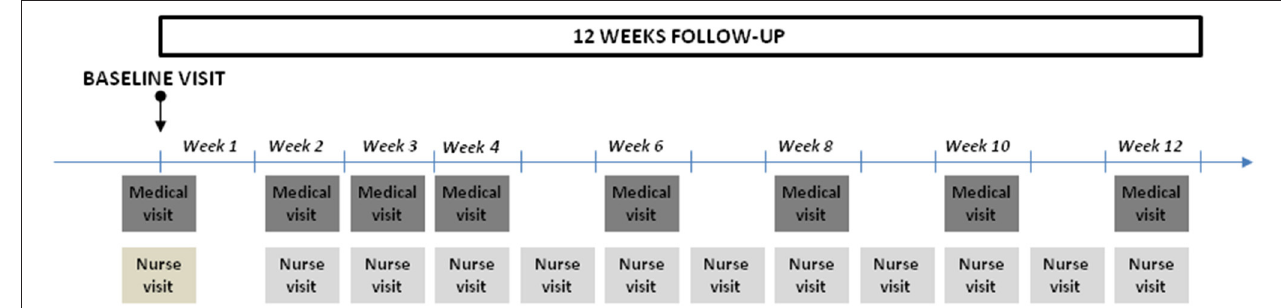
FIGURE 1 | Timeline of the follow-up.